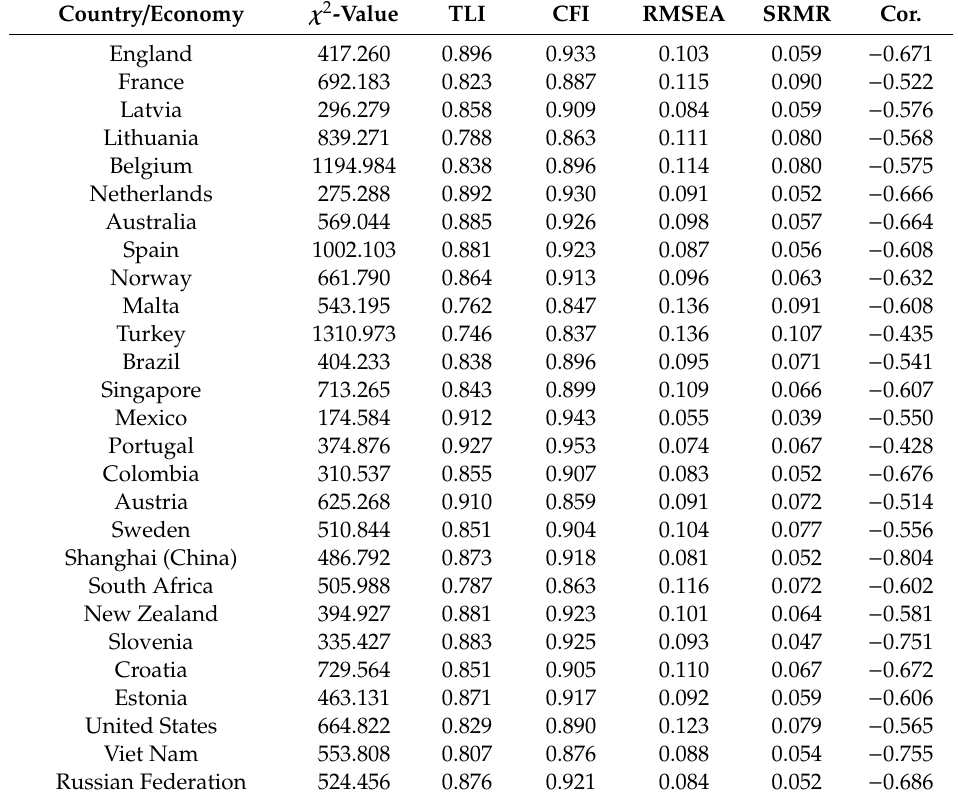
Table 3. Selected GOF indices for the first measurement models of the TALIS 2018 teacher job satisfaction